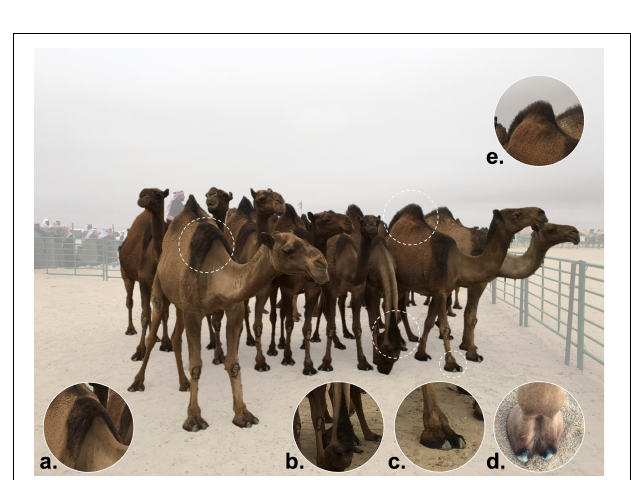
FIGURE 8 | Dark coat “highlights” of the “Syrupy” Sofor phenotype. “Syrupy” Sofor camels show a darker coat color, located on (a) the withers, (b) the top of the neck, (c,d) the dorsal footpad and toes, and (e) the tip of the hump. The name of this breed is inspired by the camel breeders’ imagination, where the camel extremities “seem” as if they were “dipped in date syrup.” Photo was taken by Hasan Alhaddad during Mutair Cultural Festival 2017, Kuwait.